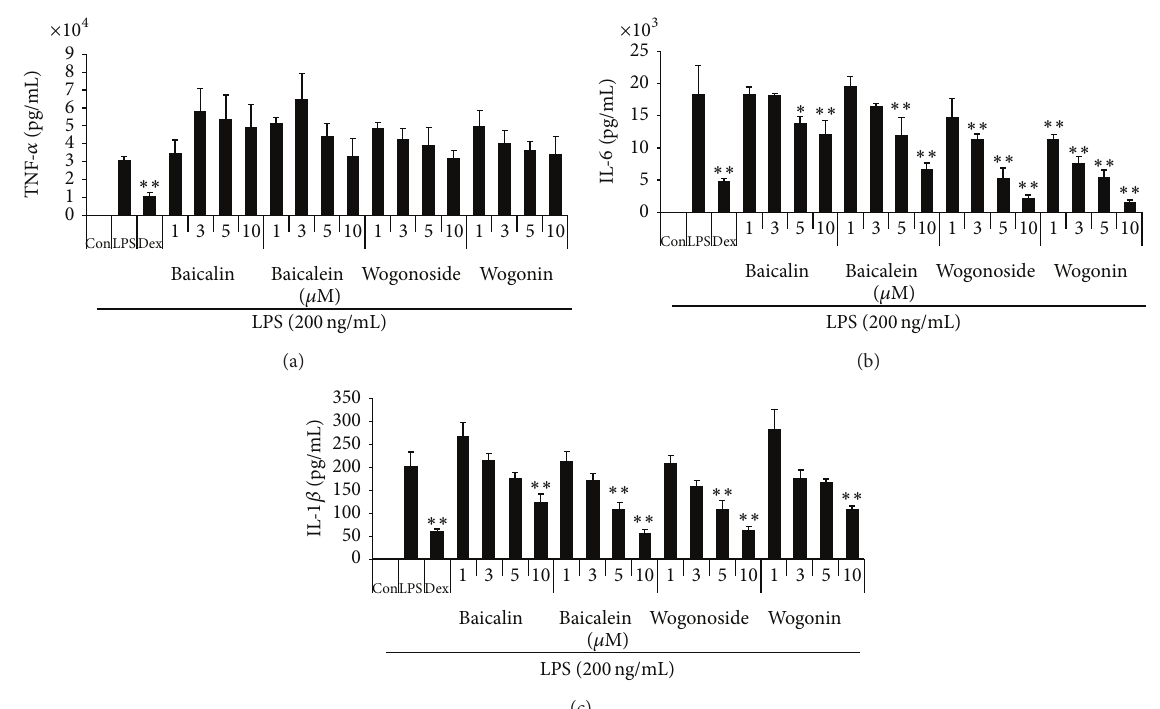
Figure 7: Effect of four compounds on the production of (a) TNF- 𝛼 , (b) IL-6, and (c) IL-1 𝛽 cytokine in macrophages. Cells were pretreated withfourcompoundsfor30minbeforebeingincubatedwithLPSfor24 h.ProductionofcytokineswasmeasuredbyELISA.Datashowsmean ± SE values of duplicate determinations from three independent experiments. ∗ 𝑃 < 0.01 and ∗∗ 𝑃 < 0.001 were calculated from comparing with LPS-stimulation